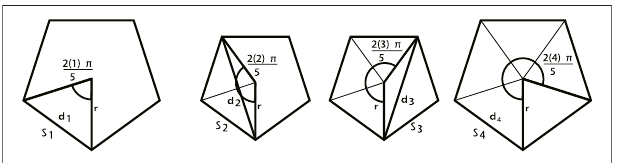
FIGURE5| Inthecaseof fi veequally-spacedtargetstheshortestround- trip distance is a regular polygon. These four polygons represent all possible polygon sizes. Taking the side length S avg gives us the average distance between targets on the minimum round-trip path shown in Eq. 30